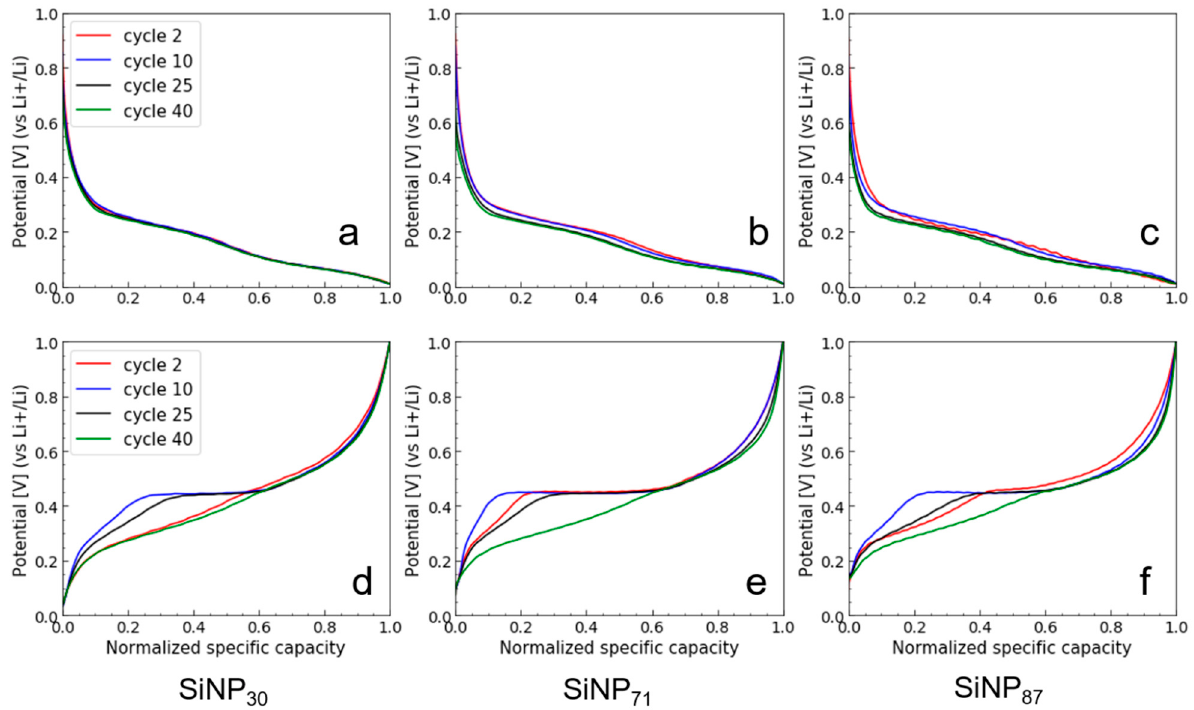
Figure 7. Normalized galvanostatic curves in lithiation ( a – c ) and delithiation ( d – f ) as a function of the cycle numbers for SiNP 30 ( a , d ), SiNP 71 ( b , e ), and SiNP 87 ( c , f ).